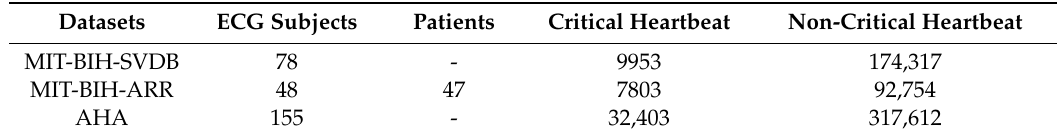
Table 4. The overall description of the heartbeat datasets.